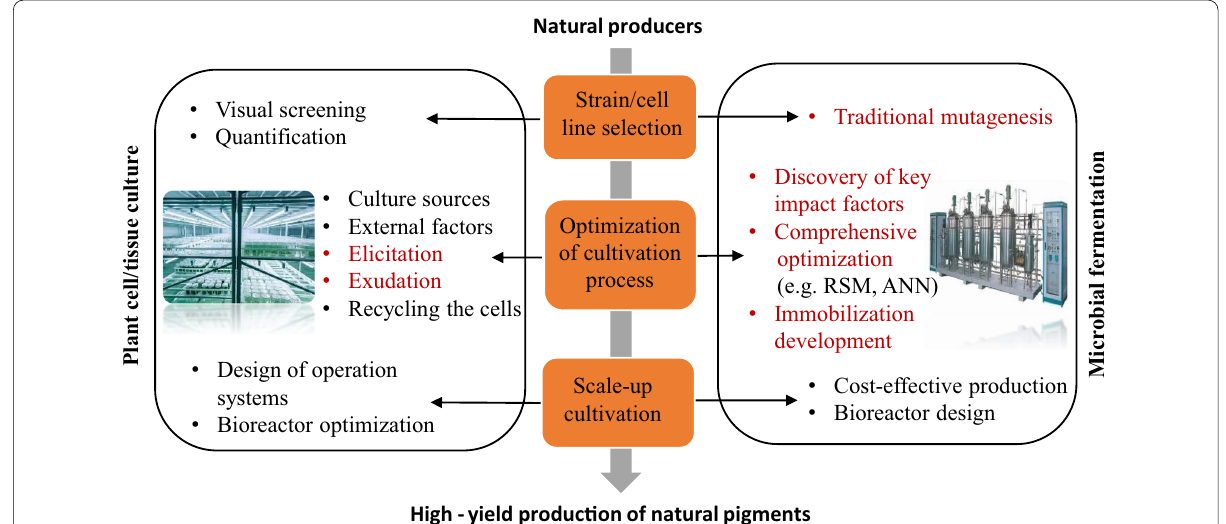
Fig. 1 Routes and strategies for improving production of pigments from natural producers, by optimization of traditional methods including plant cell/tissue culture (left) and microbial cultivation